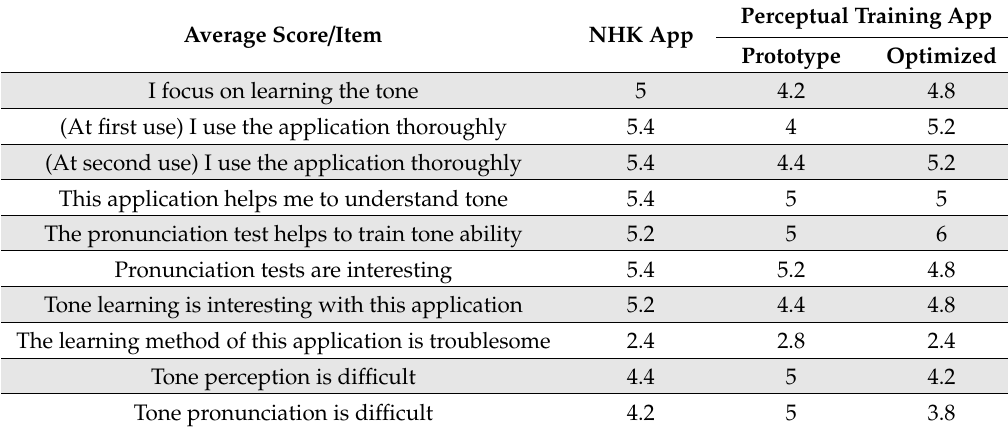
Table 1. The questionnaire result of application users (6-point Likert scale). Japan Broadcasting Corporation